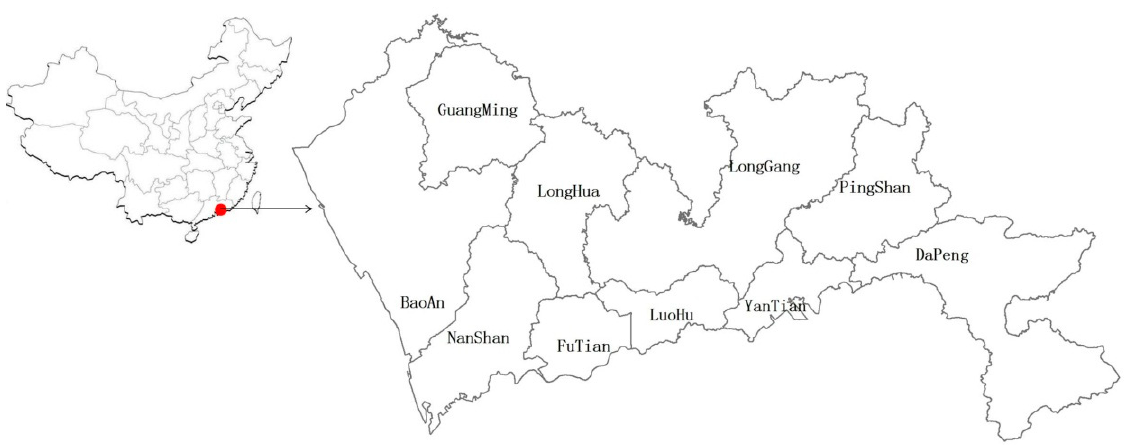
Figure 1. Location of Shenzhen in China and the districts in Shenzhen.